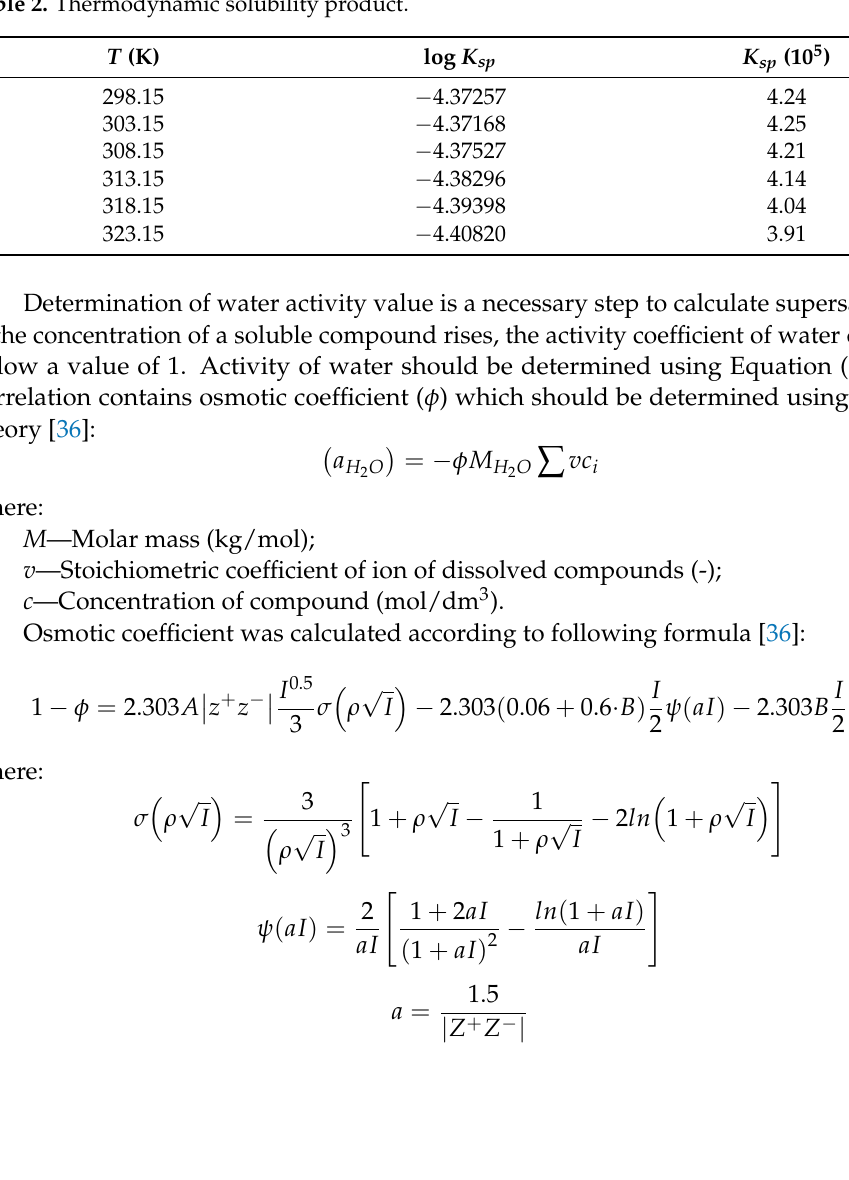
Table 2. Thermodynamic solubility